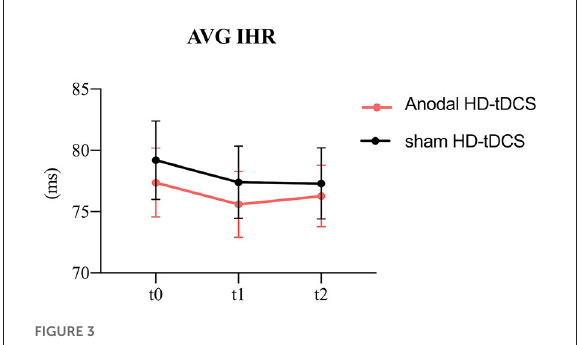
FIGURE3 Evolution of heart rate. The figure shows the intervention × time interaction for HR. Effect of the intervention on AVG IHR. Graphs show the mean values with error bars indicating 95% confidence intervals. The red line represents the Anodal HD-tDCS group and the black line represents the sham stimulation